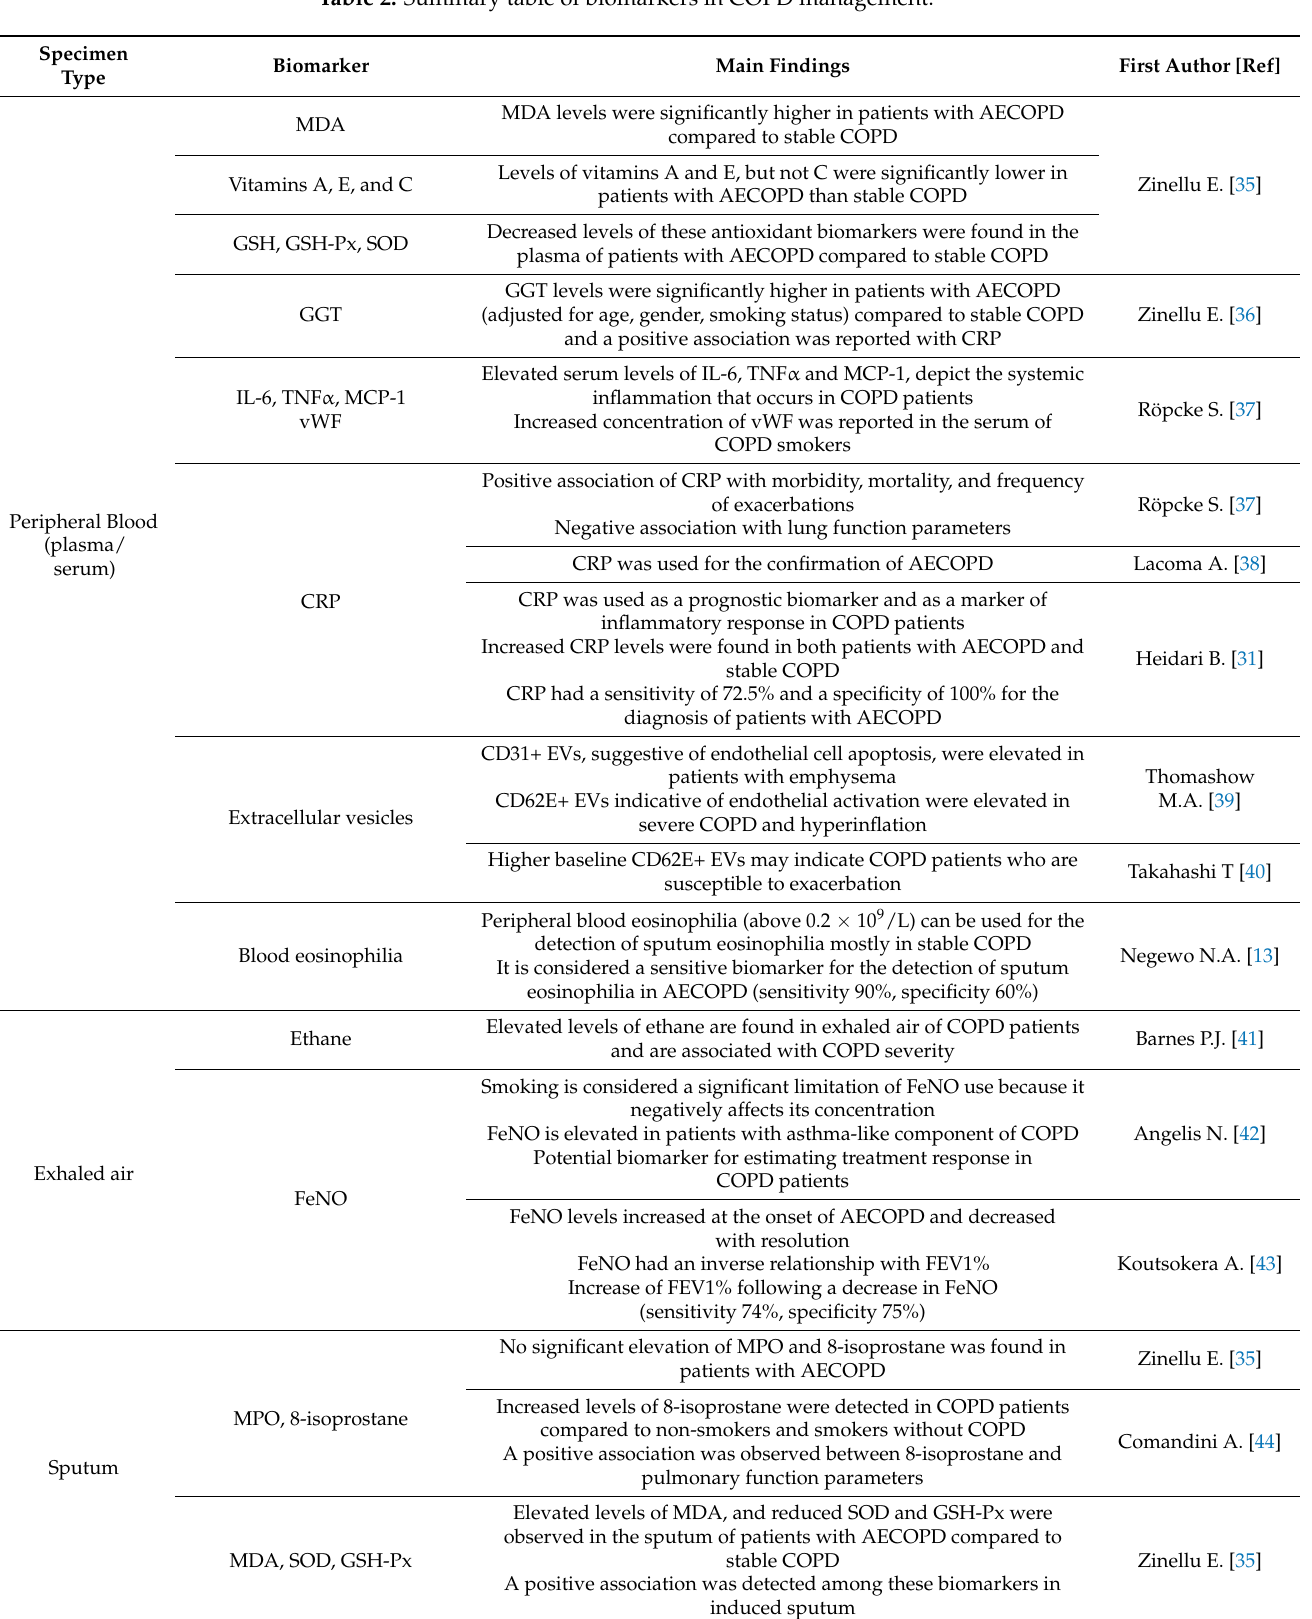
Table 2. Summary table of biomarkers in COPD